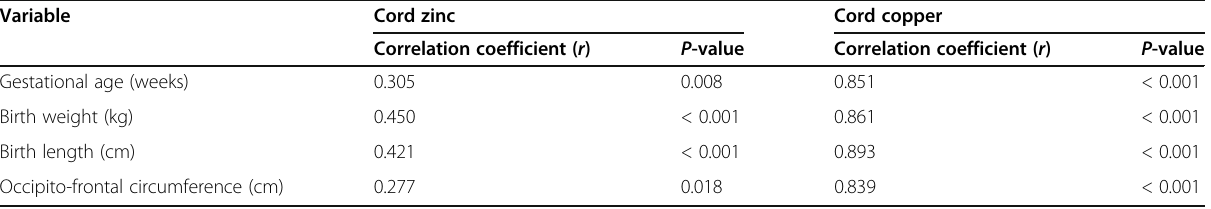
Table 3 Correlation of cord zinc and copper levels with the anthropometric measurements in the studied neonates Variable Cord zinc Cord copper Correlation coefficient ( r ) P -value Correlation coefficient ( r